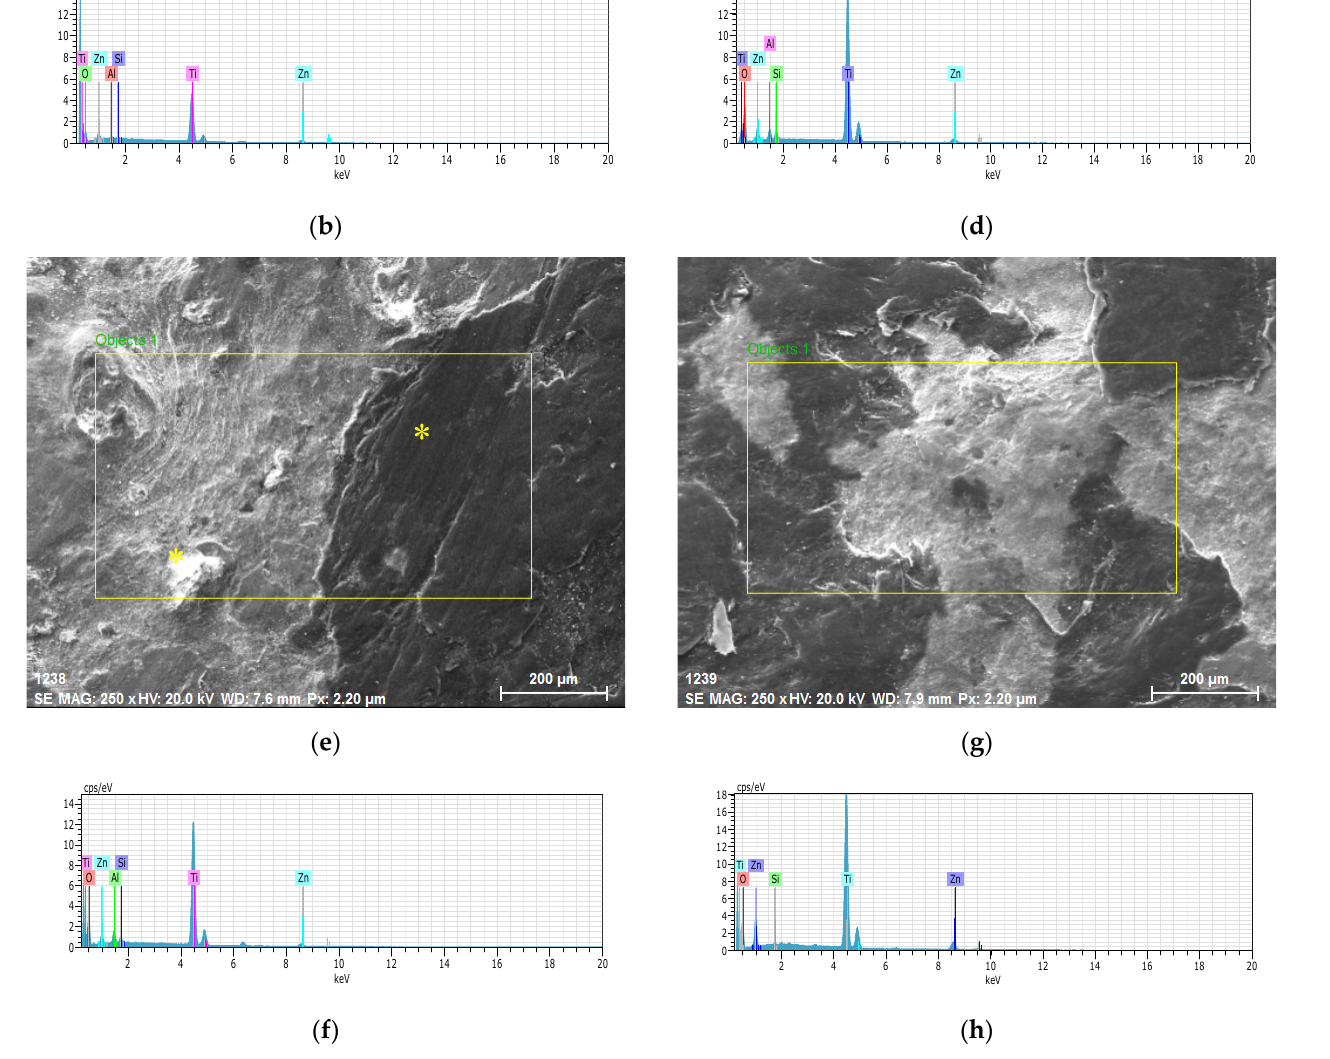
Figure 3. Ti60Si15Zn20Al5 material’s ( a ) SEM image ( b ) EDS analysis, Ti55Si15Zn20Al10 material’s ( c ) SEM image and ( d ) EDS analysis, Ti45Si15Zn20Al20 material’s ( e ) SEM image and ( f ) EDS analysis and Ti60Si20Zn20 material’s ( g ) SEM image and ( h ) EDS analysis results.